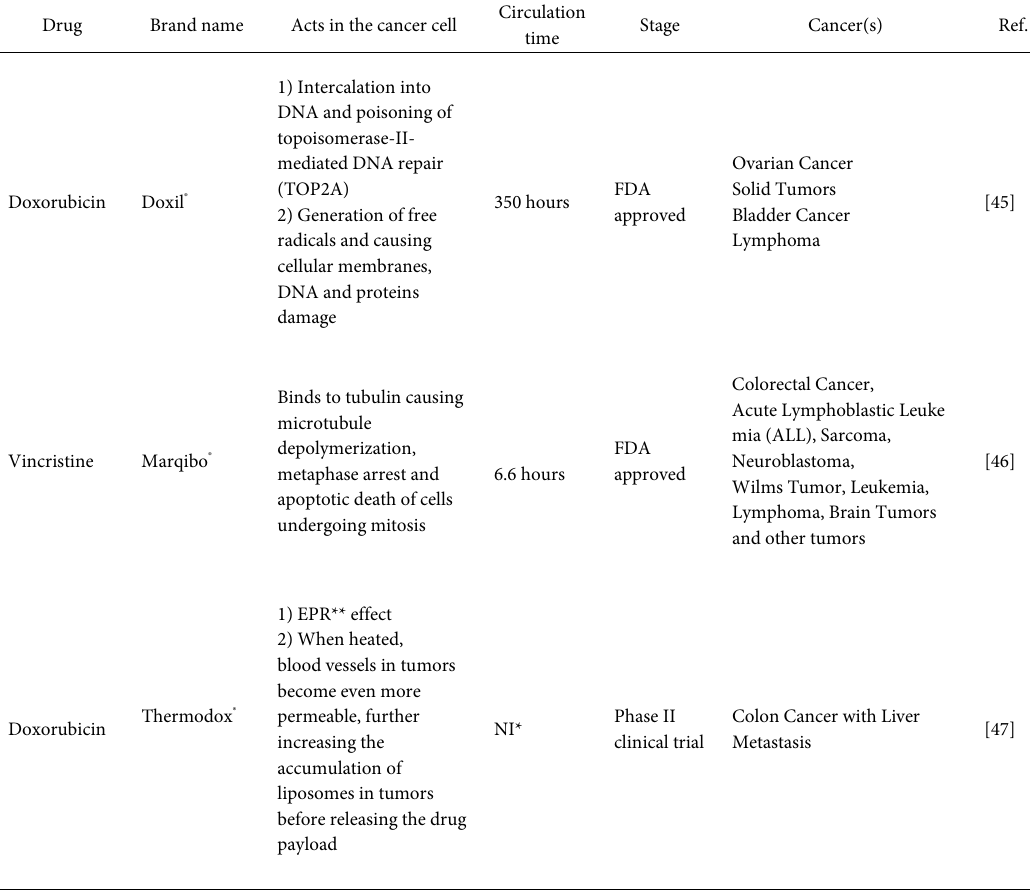
Table2 Liposomal drugs in targeting tumor cell Table 2. Liposomal drugs in targeting tumor